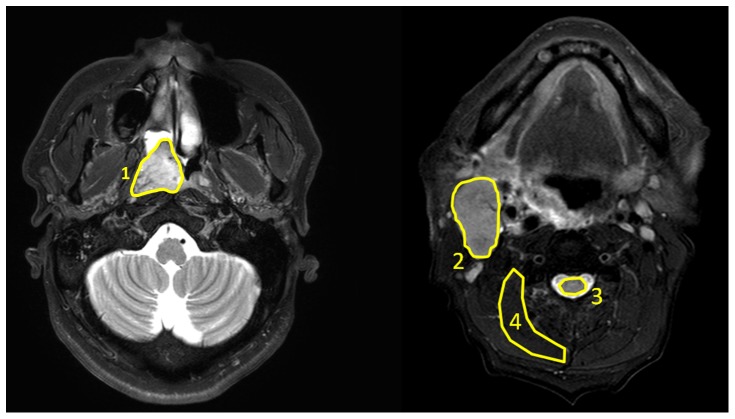
T2-weighted fat-suppressed fast-spin-echo anatomical images.Regions of interest (ROIs) were drawn on primary tumors of nasopharyngeal carcinoma (NPC), metastatic node, spinal cord and muscle and labeled as one to four respectively.